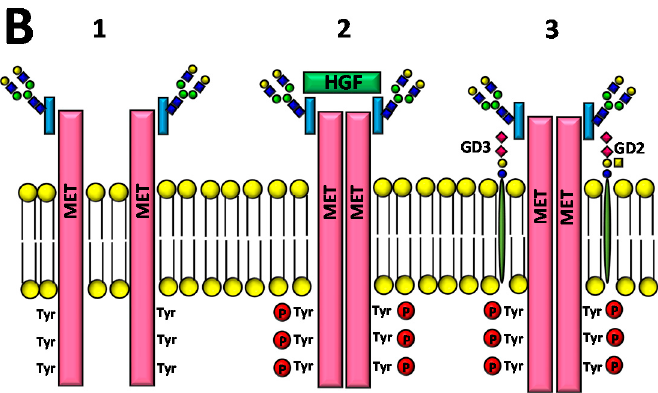
Figure 3. Effect of gangliosides on RTK activity. ( A ) Two EGFR monomers (1), in the presence of EGF, dimerize resulting in phosphorylation of tyrosine residues at their cytoplasmic portion (2). The interaction of the GlcNAc termini of the EGFR N -linked chains with ganglioside GM3 inhibits signaling (3), while interaction with GD3 reinforces it (4). ( B ) The MET receptor is comprised of a heavily glycosylated extracellular α chain (in blue) and a transmembrane β chain (in red), which undergoes phosphorylation of tyrosine residues of its cytoplasmic domain upon HGF binding (1 and 2). MET activation can be induced by interaction with disialogangliosides, such as GD3 and GD2, even in the absence of HGF (3). Sugar codes are as in the legend of Table 1.